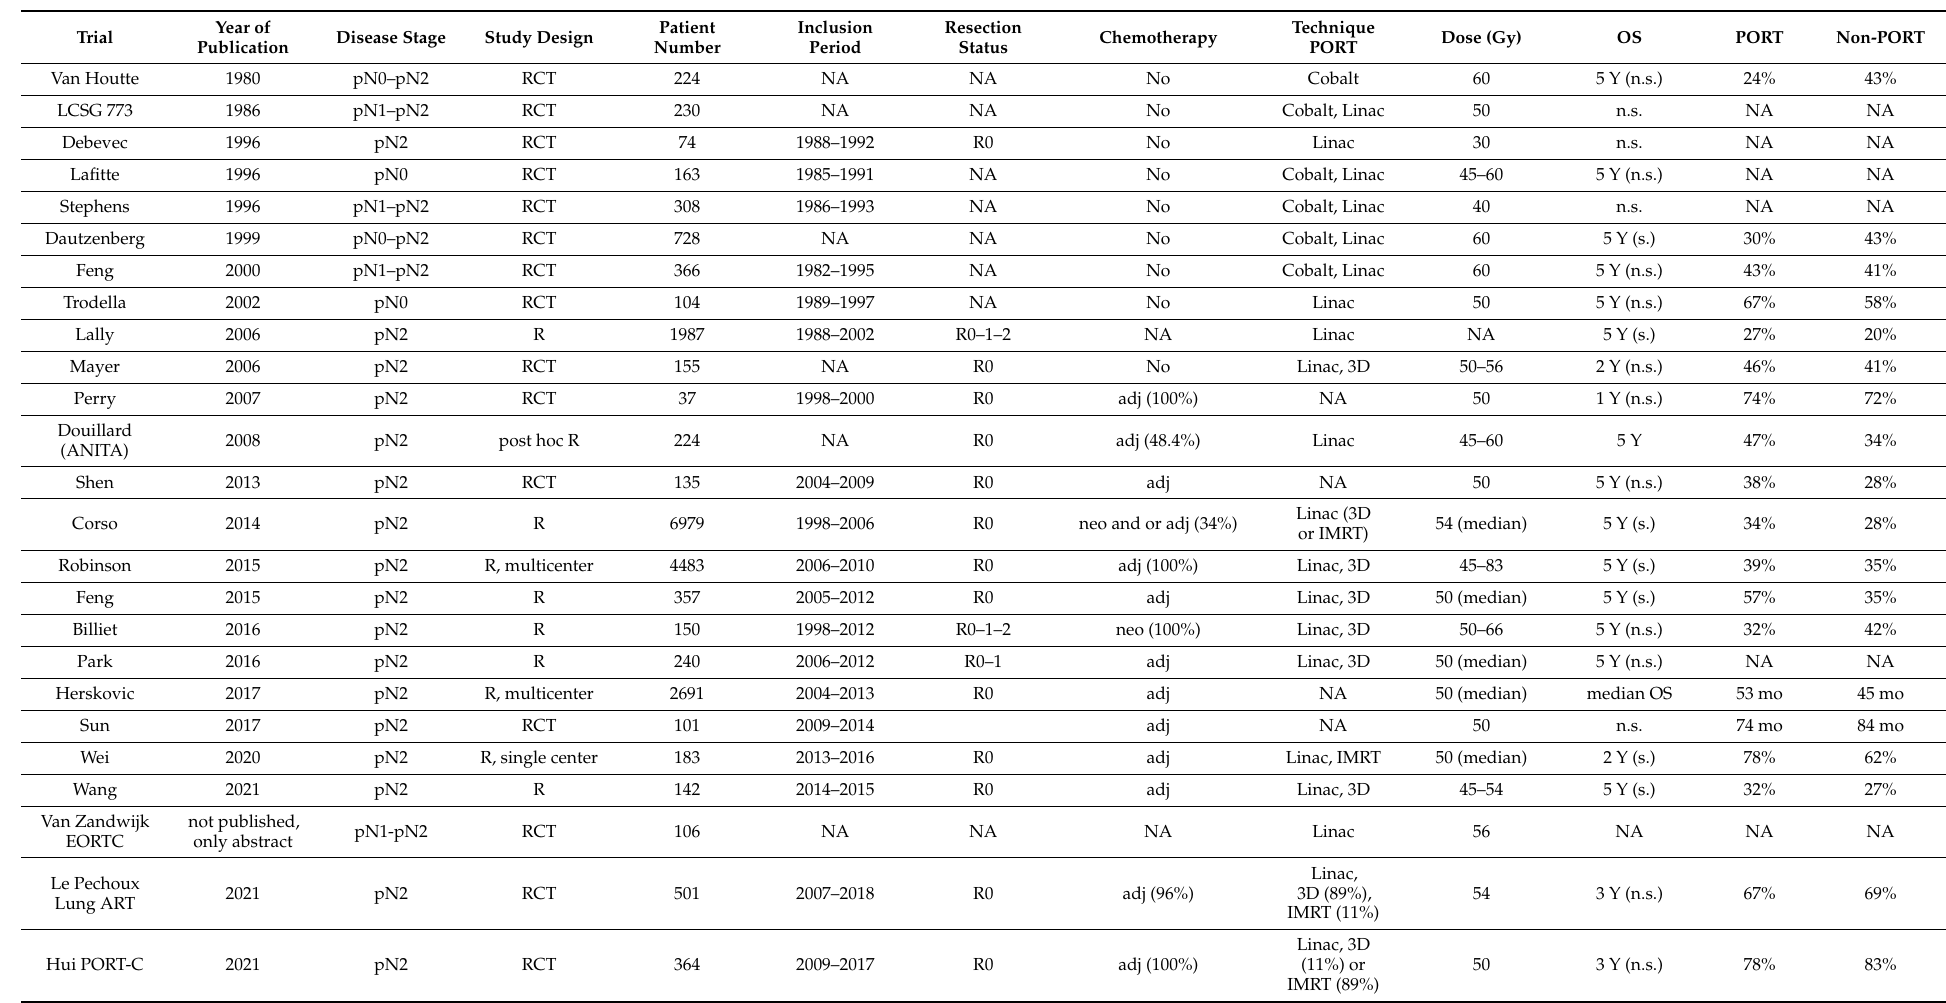
Table 1. Studies evaluating PORT in stage I–III pN0–pN2 NSCLC